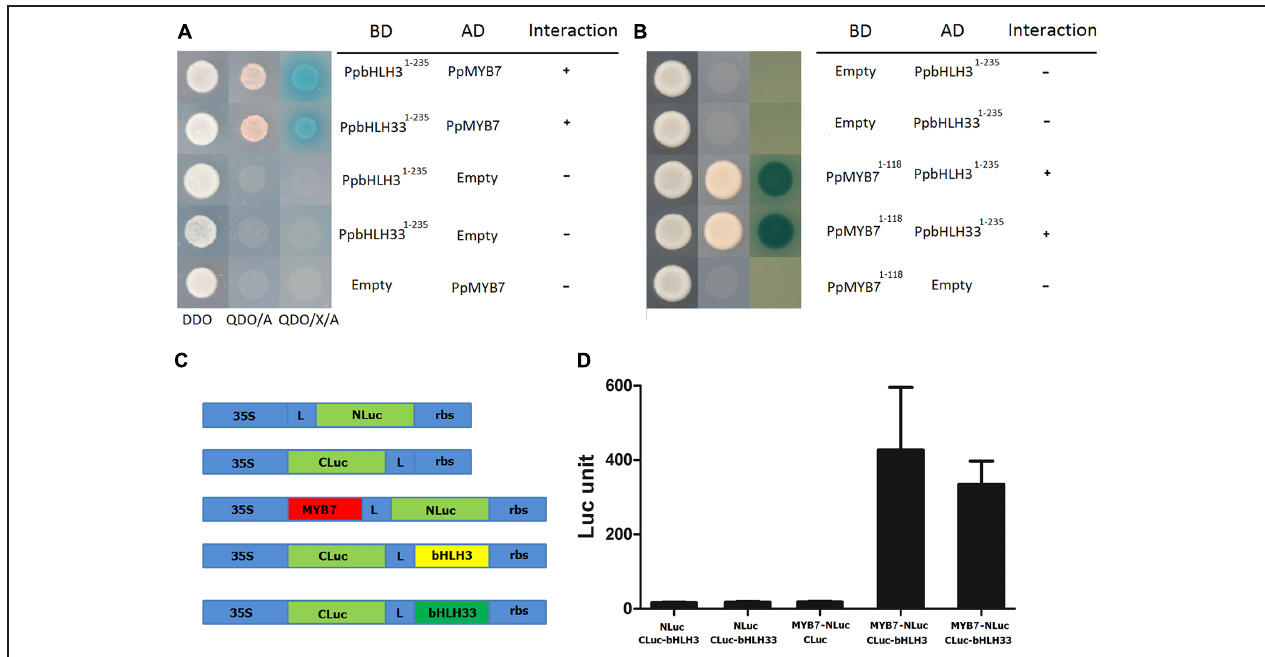
FIGURE 6 | Interaction of PpMYB7 with PpbHLH3 or PpbHLH33 in vivo . (A,B) Yeast two hybrid assay. DDO, SD-Trp-Leu medium; QDO/A, SD-Trp-Leu-Ade-His + AbA medium; QDO/X/A, SD-Trp-Leu-Ade-His + X- α -Gal + AbA medium. (C) Schematic diagram of the NLuc, CLuc, and NLuc/CLuc constructs. L, Gly/Ser linker; rbs, Transcription terminator derived from the Rubisco small subunit gene. (D) Firefly luciferase complementation assay in young N. Benthamiana leaves. The error bars stand for SE of six biological replicates.